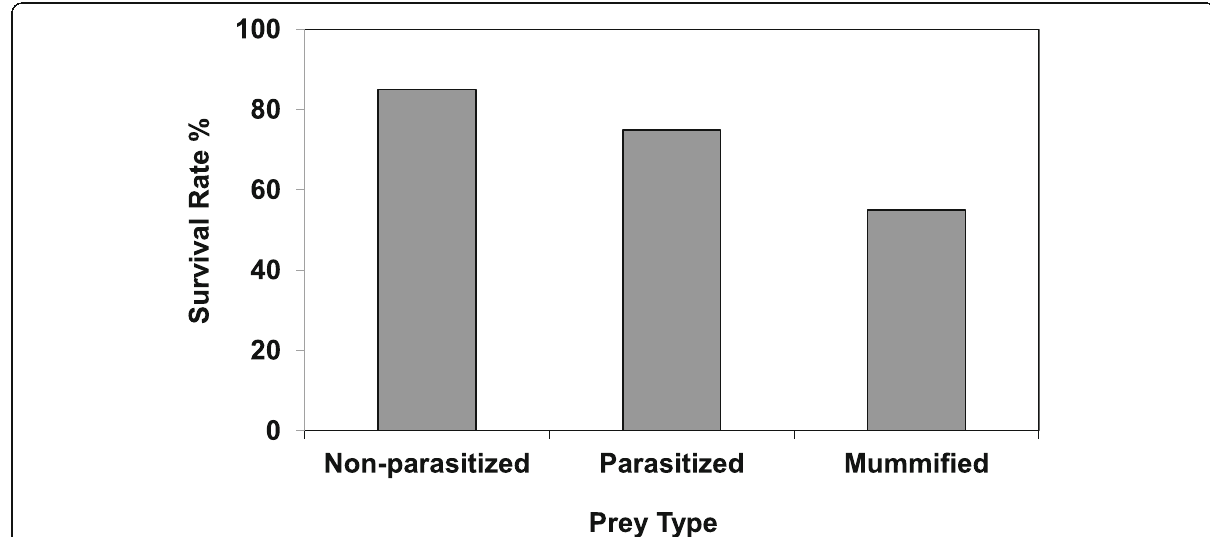
Fig. 1 Survival rate (%) of 4th instar larvae of C. septempunctata on non-parasitized ( n = 20), parasitized ( n = 20), and mummified ( n = 20) aphids. X -axis represents type of the prey offered, while Y -axis shows the survival rate (%) of 4th instar larvae of C. septempunctata ( χ 2 test, p ≤ 0.037